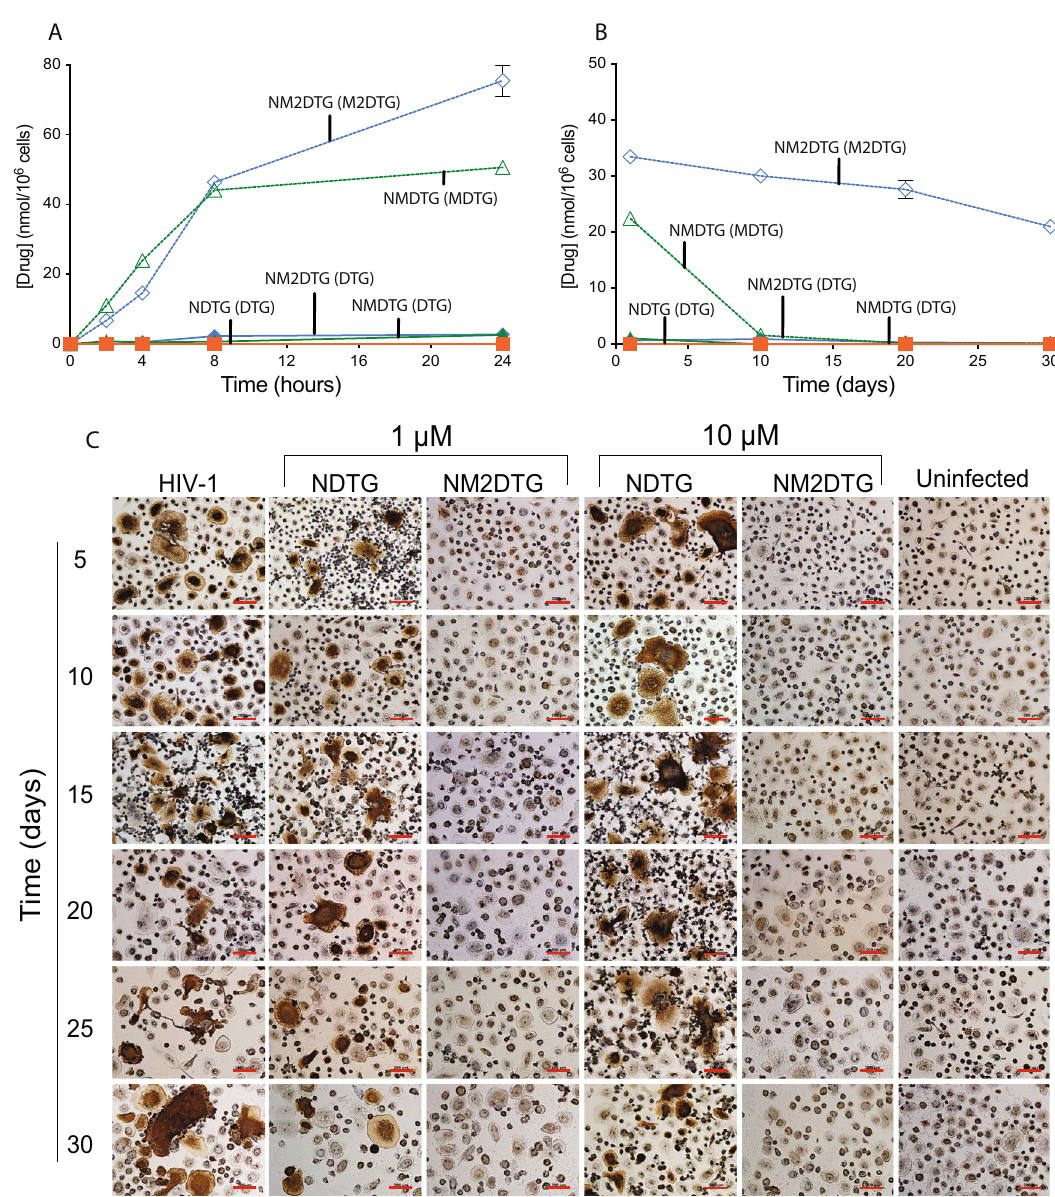
Fig. 2 In vitro characterization of NM2DTG in MDM. A Drug uptake and B retention in monocyte-derived macrophages (MDM) were measured over 24 hours and 30 days, respectively, after treatment with prodrug nanoformulations at a concentration of 25 μ M. Results are expressed as the mean ± SEM for N = 3 biological replicates. C Antiretroviral responses were recorded after HIV-1 ADA challenge at a multiplicity of infection (MOI) of 0.1 infectious virions/cell at recorded times following treatment with either NDTG or NM2DTG at 1 or 10 μ M concentrations for 8 h. HIV-1p24 antigen levels were assessed in fi xed MDM by immunohistochemical staining. N = 4 biological replicates. Representative images were taken at ×20 magni fi cation. Scale bars — 200 μ m. Source data are provided in the Figshare database under Digital Object Identi fi er (DOI) code https://doi.org/10.6084/m9. fi (Supplementary Fig. 15). Quanti fi cation of the CES isoforms half of the prodrug solution was depleted at 48 h (Fig. 5A, E). demonstrated that CES1 was the most dominant. Notably, no However, the prodrug solution was rapidly cleaved in plasma, while relationships were found between CES levels and prodrug cleavage heat-inactivation led to a signi fi cant reduction in the rates of plasma rates, indicating the process of the native prodrug to drug release was cleavage (Fig. 5G, H). Prodrug to parent drug conversion was cal- independent of a speci fi c CES. Next, we investigated the stability of culated (Supplementary Fig. 17A – F). The lymph node showed the solubilized and nanoformulated M2DTG solid drug suspensions, in most rapid cleavage rates of the nanoformulation. Notably, the rat tissue homogenates, to assess time-dependent prodrug tissue spleen and kidney showed the highest rate of prodrug cleavage when cleavage. The prodrug formulation remained stable in all tissue exposed to the prodrug solution. The decreasing concentration of matrices tested (Fig. 5A – H). The fi ndings were cross-validated by total prodrug levels in the tissue homogenates followed second-order quantifying parent drug levels from the same samples. The prodrug kinetics for all nanoformulation and most solution sample sets; with solution showed complete cleavage in the spleen and kidney the rates obtained from the incubation of the solution in the spleen homogenates at 48 h (Fig. 5C, D). For liver and muscle tissues, only and kidney following mixed order kinetics.